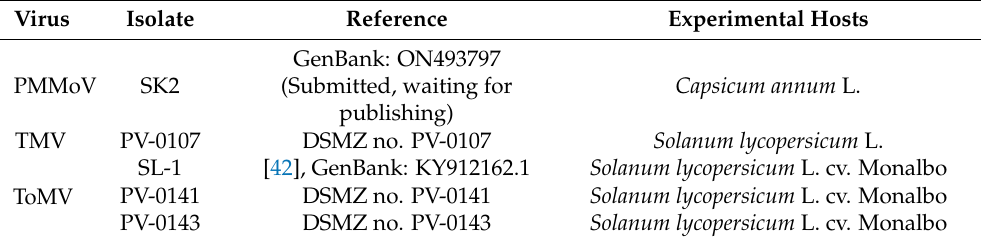
Table 1. Tobamovirus isolates used for inoculation of D. stramonium L.